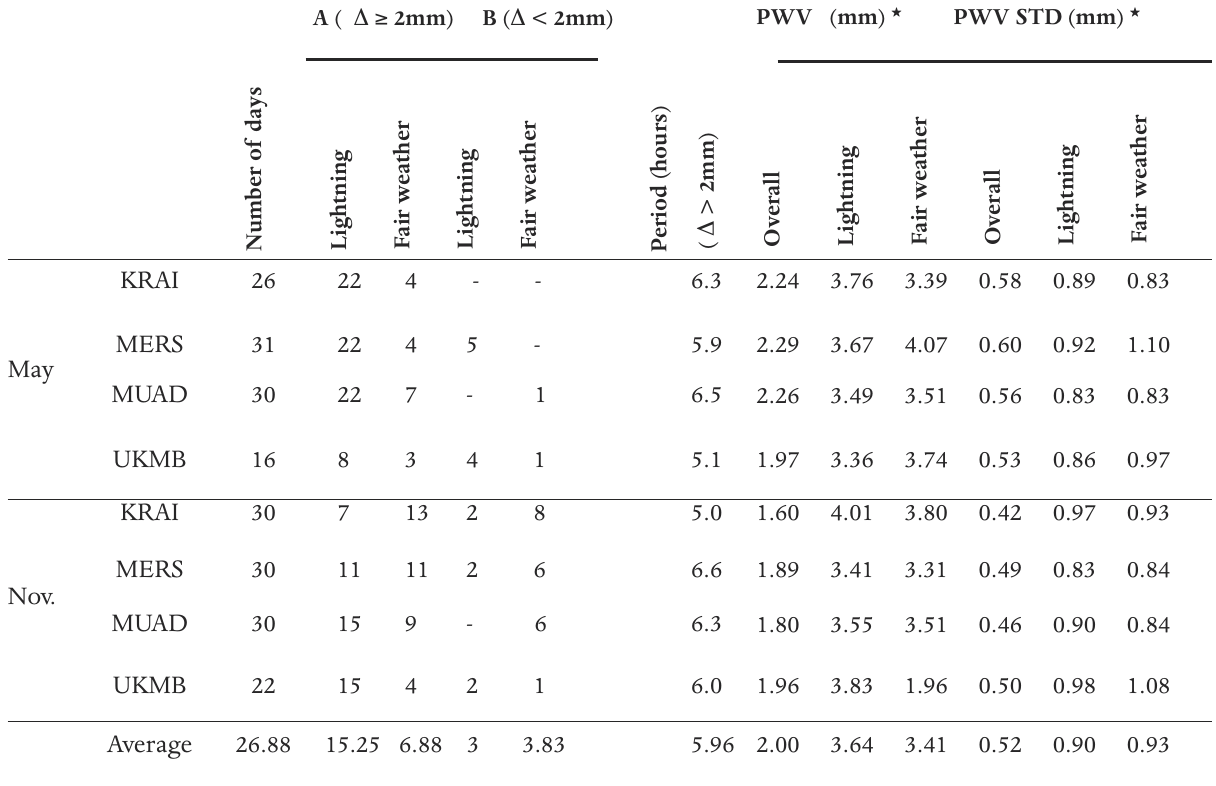
* Δ and STD are for PWV values, Table 5. The impact of PWV during the lightning and fair weather conditions for 2009 inter-monsoons.